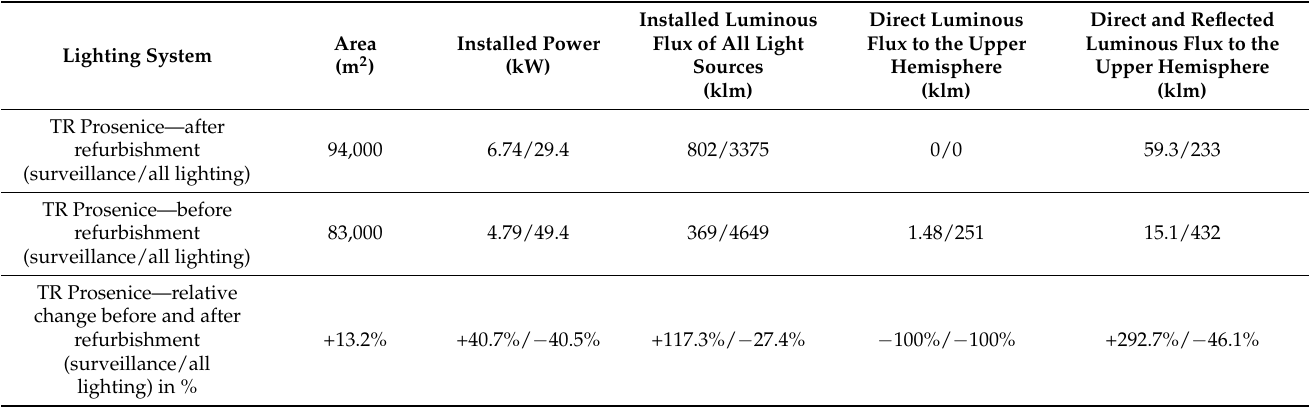
Table 7. Comparison of the operational modes of the TR Prosenice electric station before and after